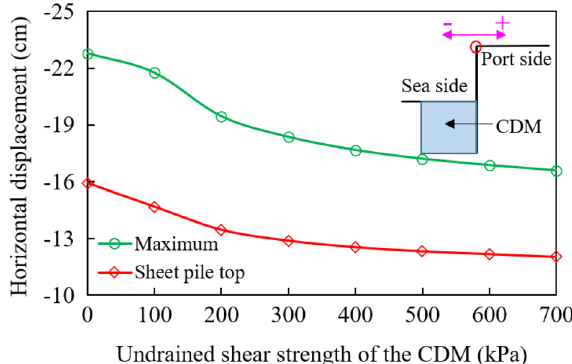
Fig. 14 Change of horizontal displacement with the strength of CDM (the Coalinga